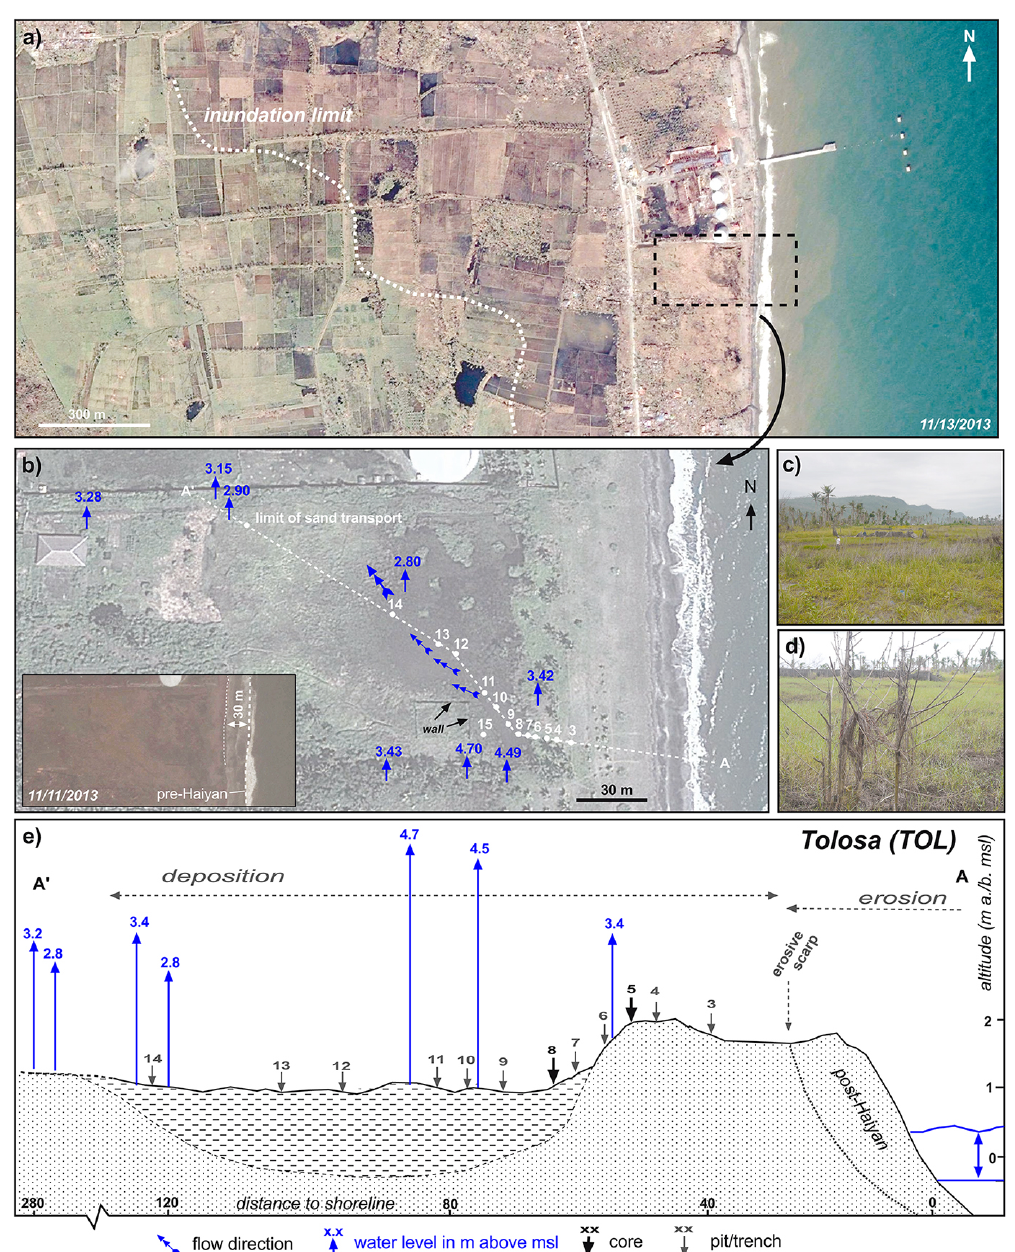
Figure 5. Tolosa (TOL) study site with documented Haiyan flood marks and positions of sampled typhoon deposits. (a) Local inundation limit reached several 100m inland (based on Google Earth/Digital Globe, 11 November 2013, i.e. immediately after Haiyan). (b) Onshore sediments were investigated along a transect (A–A (cid:48) ) crossing the inundated area (based on Google Earth/Digital Globe, 23 February2 2012; insert: Google Earth, 11 November 2013) (c) Westward view from the beach ridge over the back-barrier marsh. (d) Flood debris in bushes served as an indicator for flow depth. (e) With flow levels of at least 4.5m above msl, Haiyan flooded the beach ridge entirely and transported sand about 150m